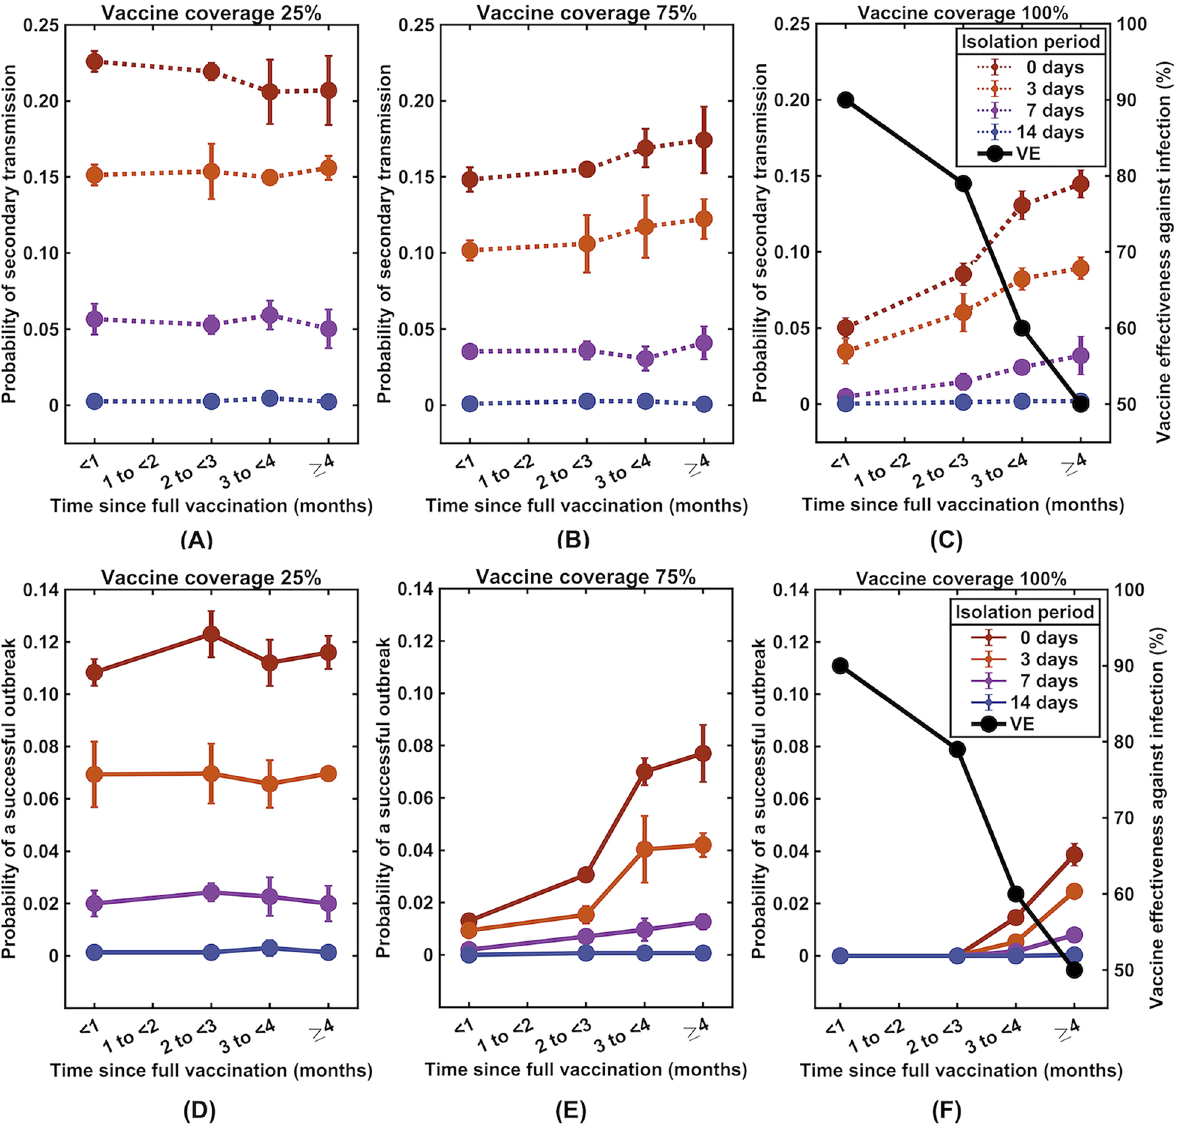
following the release of a breakthrough infectious individual from isolation as the vaccine effectiveness against infection wanes (black lines, right y-axis). Data on vaccine effectiveness against infection were obtained from reference 23